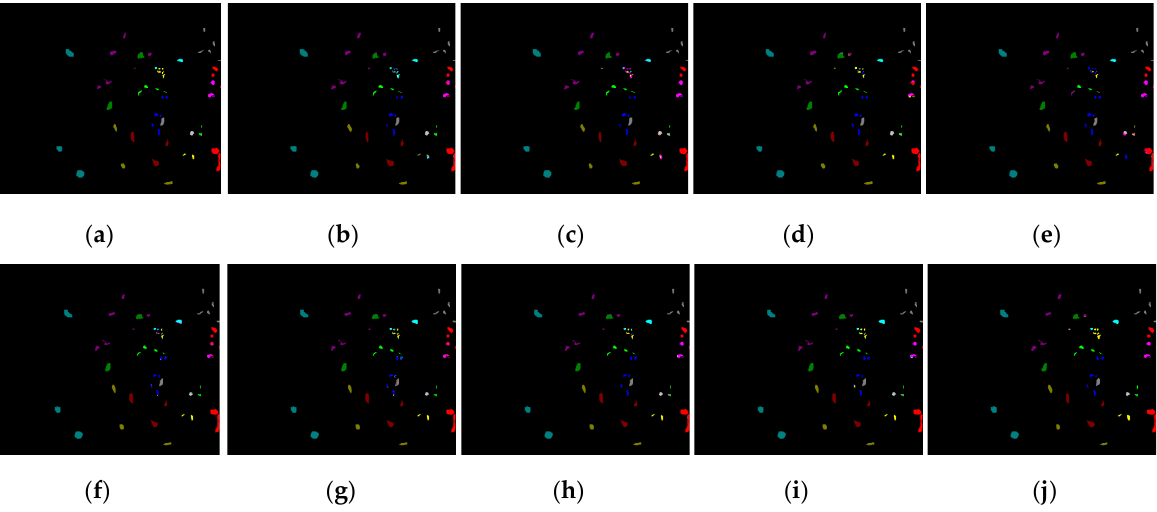
Figure 8. The classification results of KSC dataset. ( a ) Ground Truth; ( b ) RBF-SVM; ( c ) EMP-SVM; ( d ) CNN; ( e ) ResNet; ( f ) MLP-Mixer; ( g ) RepMLP; ( h ) DFFN; ( i ) DMLP; ( j ) DMLPFFN.